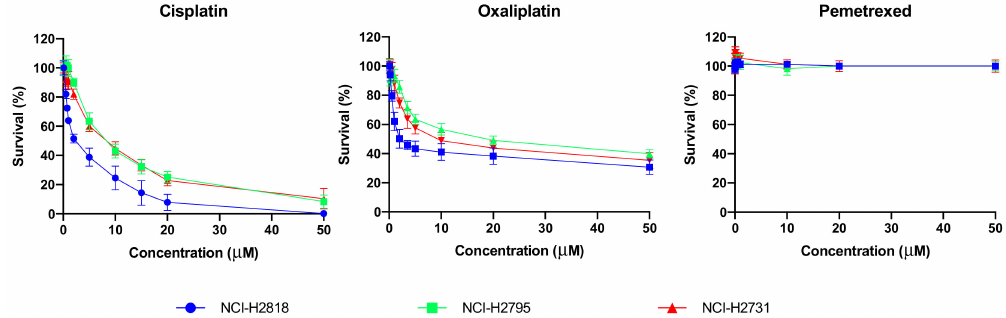
Figure 1. Dose-response curves of cisplatin, oxaliplatin and pemetrexed treatment. Each graph illustrates the survival curve of our three MPM cell lines after 72 h of treatment with either cisplatin, oxaliplatin or pemetrexed. The error bars indicate the standard deviation ( n = 3). Statistical analysis showed significant di ff erences for cisplatin ( p = 0.001–0.020) and oxaliplatin ( p = 0.001–0.009) sensitivity of the di ff erent cell lines.